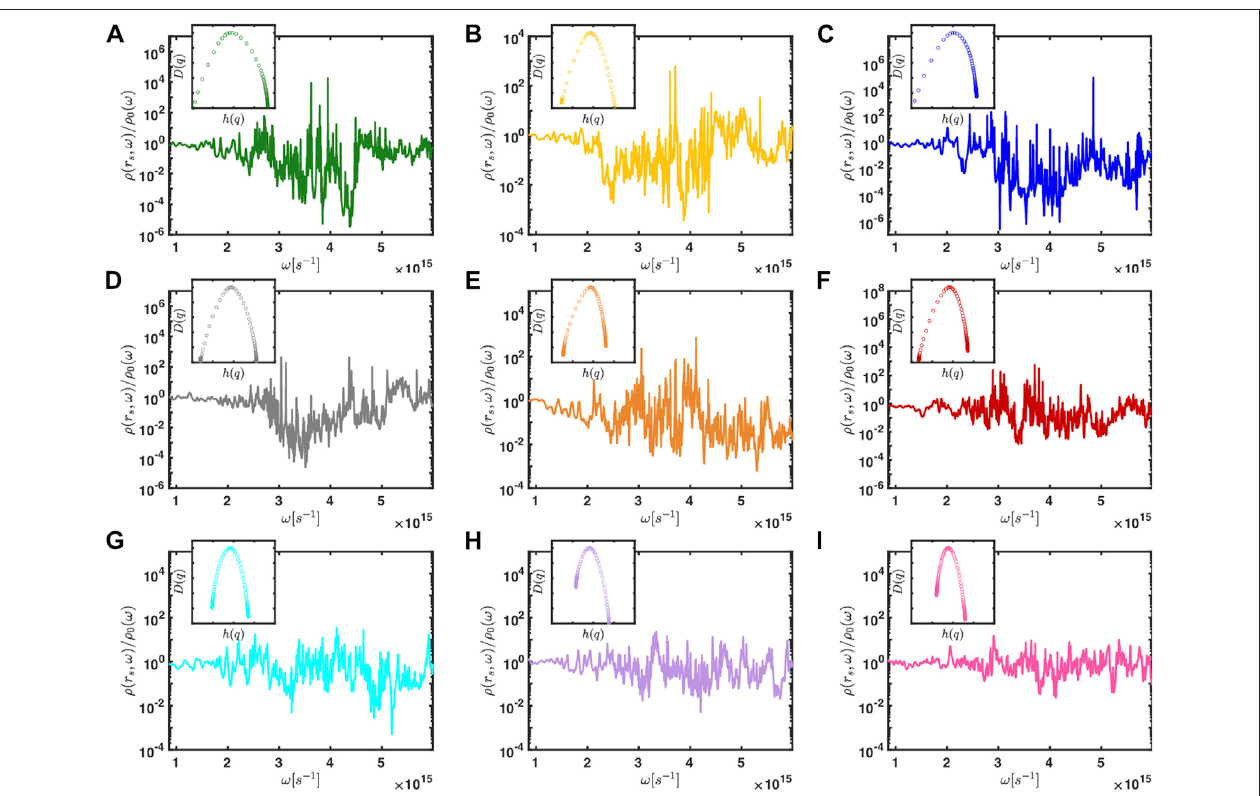
FIGURE 9 | (A – I) LDOS/Purcell enhancement as a function of frequency ω of vertically polarized dipoles (i.e., electric fi eld along the z) spatially arranged according to the distributions of complex primes in the imaginary quadratic fi elds shown in Figure 1 . The insets show the corresponding multifractal spectra D ( q ) as a function of h ( q ). All the multifractal spectra are reported on the same scale with D ( q ) ∈ [0, one] and h ( q ) ∈ [0,